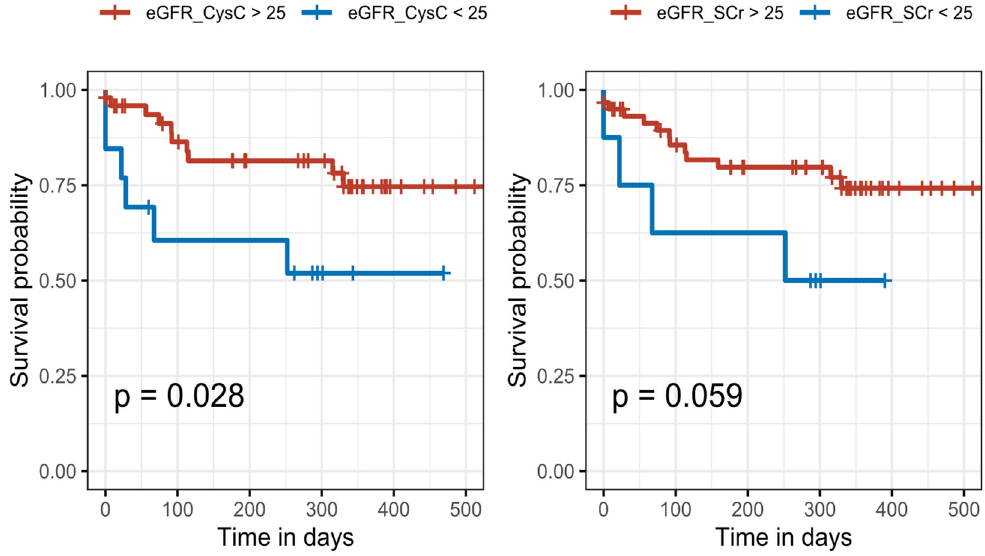
Figure 5. Kaplan–Meier survival curves according to eGFR levels using CysC ( left ) and SCr ( right ) in patients with eGFR below and above 25 mL/min/1.73 m 2 in the first follow-up measurement. There were 49 deceased patients with eGFR CysC below 25 and 13 with eGFR CysC above 25, and 60 deceased patients with eGFR SCr below 25 and 8 with eGFR SCr above 25.